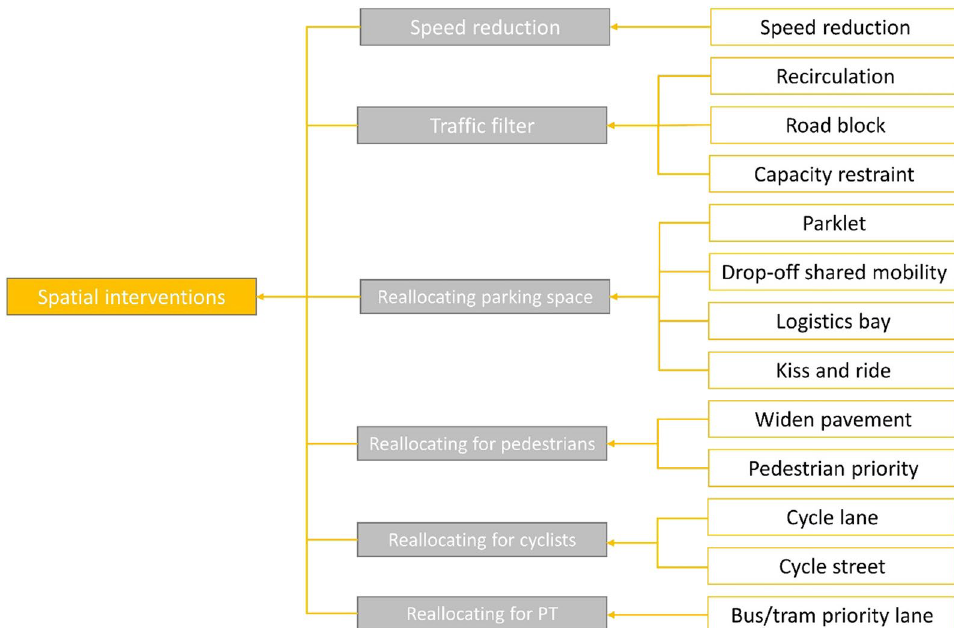
Fig. 3 Schematic for the UVAR taxonomy for the category of spatial